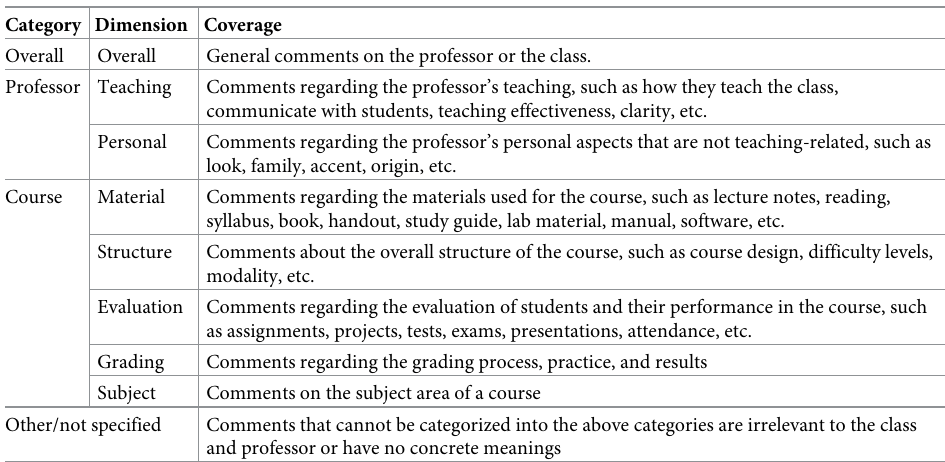
Table 2. Dimensions and coverage of topics.